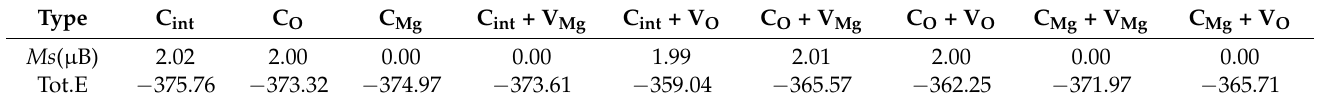
Table 1. Magnetic moment of different defect configurations in C-implanted MgO.